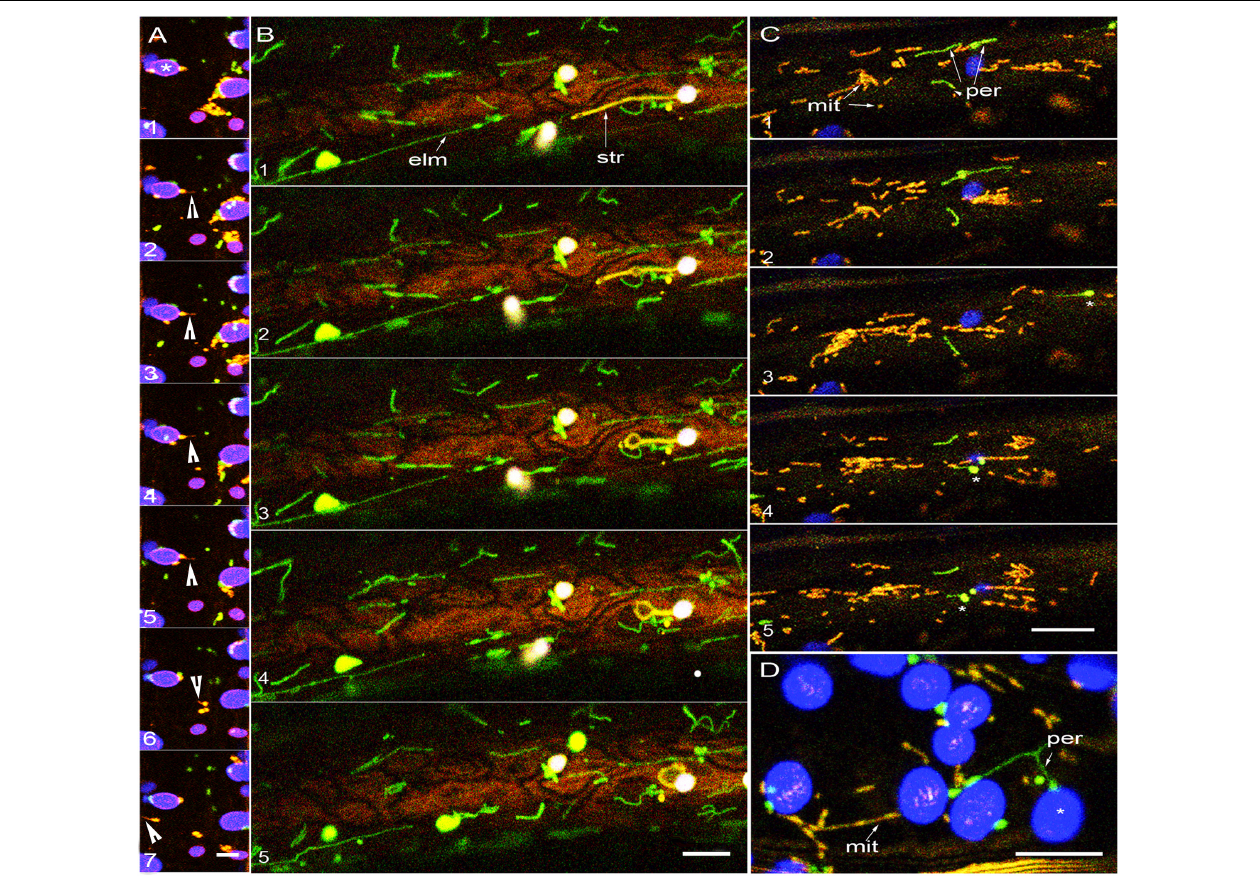
FIGURE 2 | Tubular forms do not increase proximity between plastids, mitochondria and peroxisomes. (A) Sequential images taken after 5 min of exposure to about 450 µ mol m − 2 s − 2 of light show mild organelle clustering and a quick matrixule (arrowhead) extension response by a mitochondrion in apparent proximity to a chloroplast (*). Panel 7 and 8 show other mitochondria extending matrixules independently (arrowheads). While mitochondria and peroxisome remain around the lower chloroplast (*) the cluster around the other chloroplasts disperse over time suggesting that dwell time and organelle dynamics can vary considerably even in neighboring regions of the cell (see Supplementary Movies 2 , 3 ). (B) Five sequential images from a single hypocotyl cell from a non-stressed double transgenic elm1 mutant with elongated green fluorescent mitochondria (elm- arrow) and stroma targeted YFP. The elongated mitochondria do not interact with the extended stromule (str- arrow) that exhibits independent dynamic behavior ( Supplementary Movie 4 ). (C) In non-stressed double transgenic apm1 mutant elongated mitochondria (yellow -mit) and peroxisomes (per- green) pass by each other without showing sustained proximity. Peroxules (*) seen in panels 3, 4, 5 do not exhibit sustained proximity with the elongated mitochondria streaming around them ( Supplementary Movie 5 ). (D) Representative snapshot from a double transgenic apm1 mutant cell stressed by exposing to 450 ± 25 µ mol m − 2 s − 2 for 10 min suggests increased proximity between chloroplasts (* blue) elongated peroxisomes (per-green) and mitochondria (mit- yellow). Scale bars – A = 5; B, C, D = 10